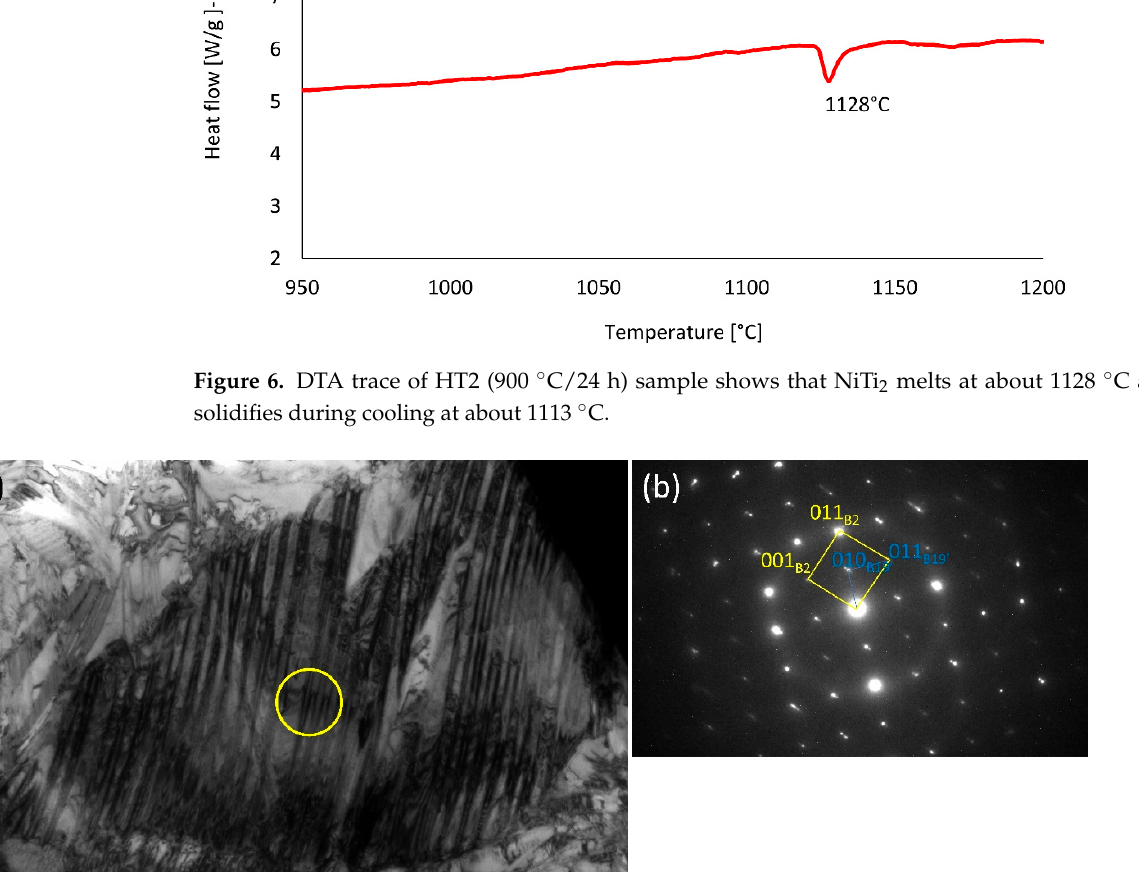
Figure 7. ( a ) A bright-field image of the NiTi matrix; ( b ) with a corresponding SAED pattern from (an area marked by a yellow circle).